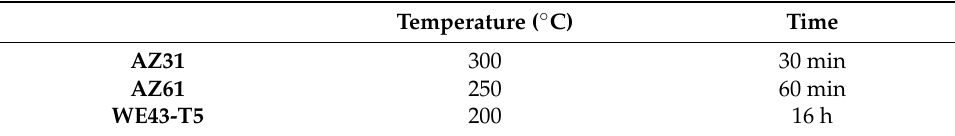
Table 2. Heat treatment of alloys AZ31, AZ61, and